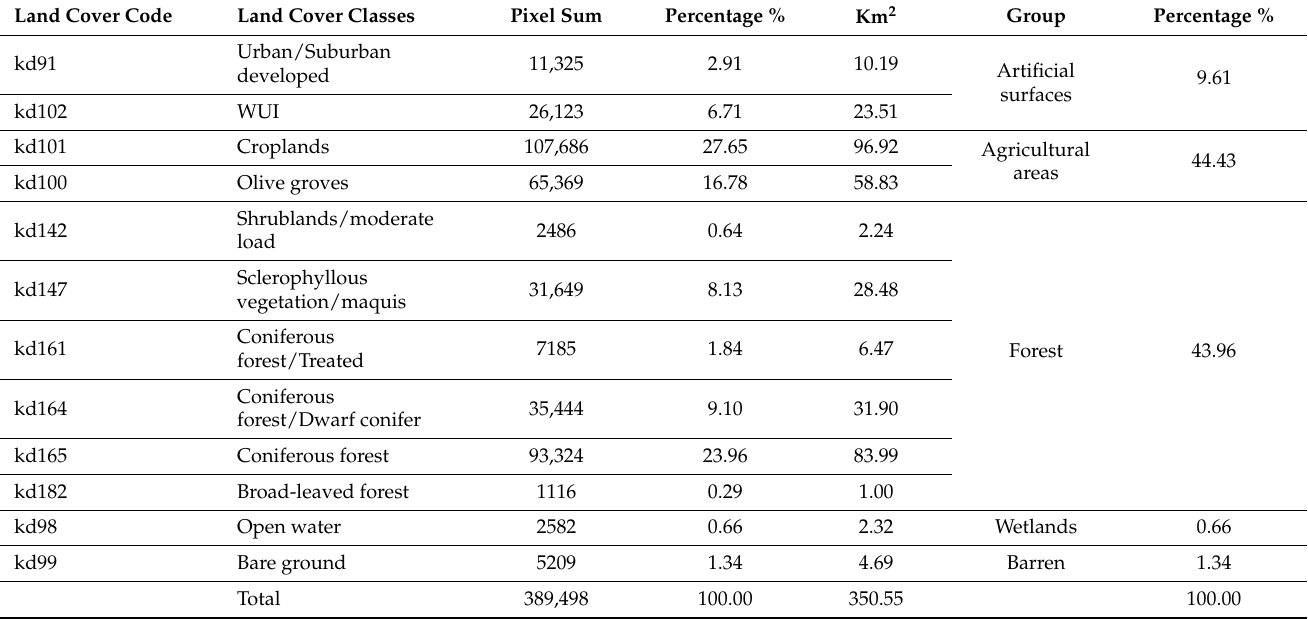
Table 2. KASSANDRAS’S DATASET land cover codes and classes grouped in five general